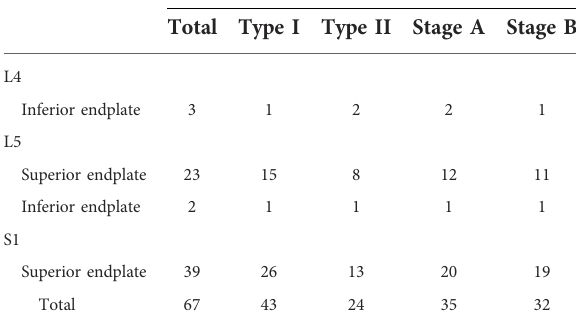
TABLE 3 Postoperative type and stage.